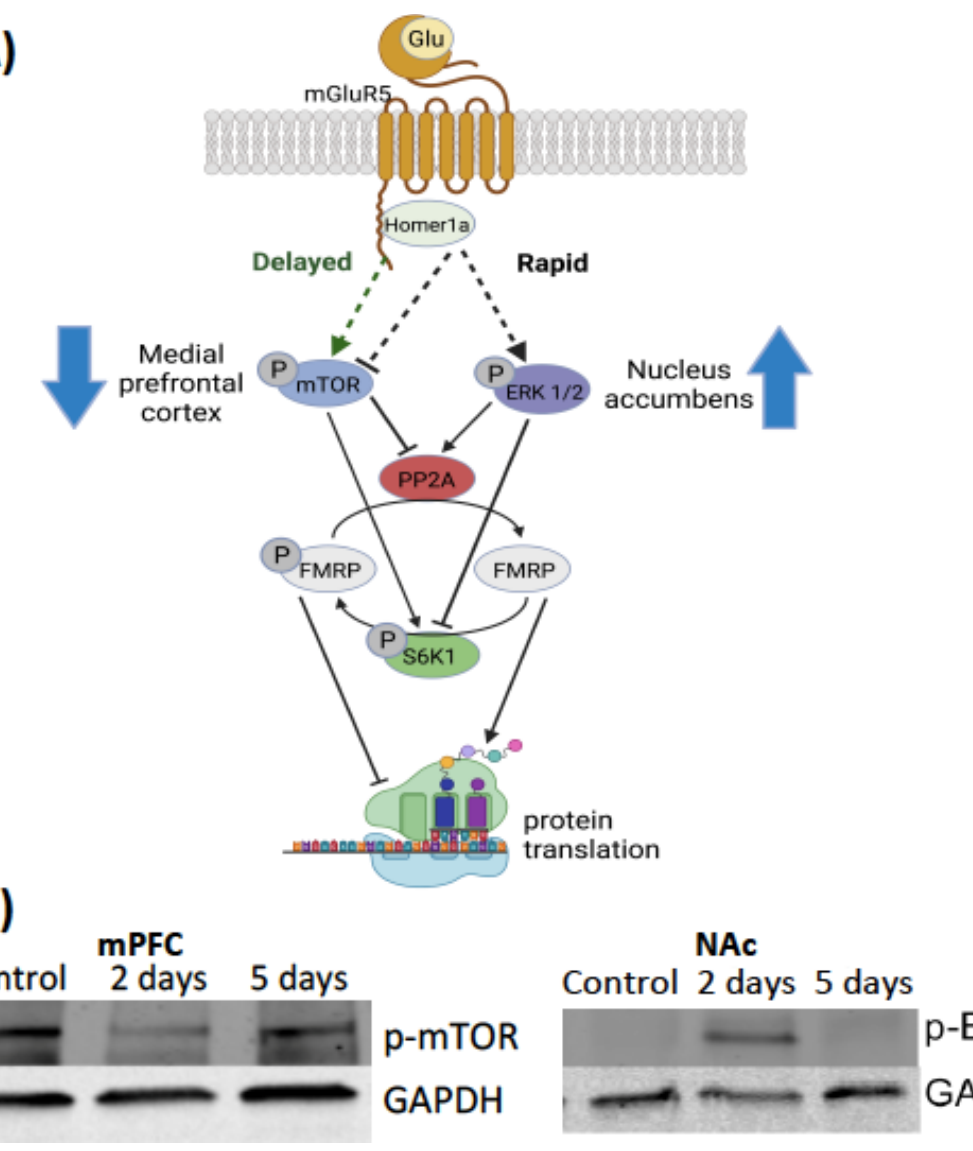
Figure 4. Hypothesized model of intracellular signaling molecules regulating FMRP phosphorylation and de-phosphorylation. ( A ) Shortly after aggressive interactions there is a decrease in the phos- phorylation of mTOR in the mPFC and an increase in the phosphorylation of ERK1/2 in the NAc. Immediately following the activation of mGluR5 there is an increase in the activity of ERK1/2 and PP2Ac and a decrease in the activity of S6K in the nucleus accumbens. This pushes the balance of the activity of FMRP towards a decrease in phosphorylation, resulting in the translation of protein. However, in the medial prefrontal cortex following the activation of mGluR5 there is a decrease in the activity of mTOR, which would increase the activity of PP2Ac and decrease the activity of